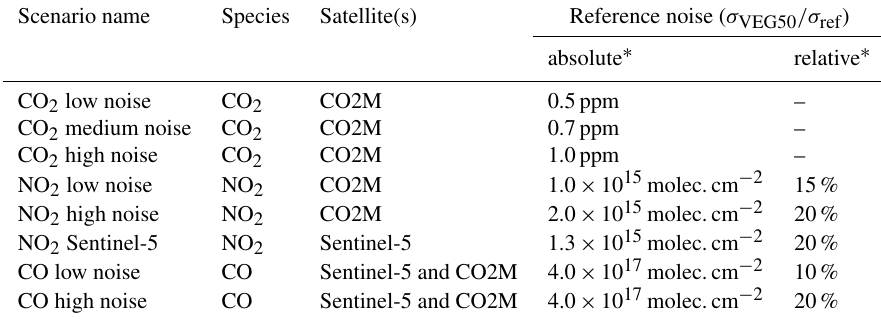
Figure 2. Spatial coverage of one CO2M satellite within its 11d repeat cycle (a) globally and (b) over Europe. The white square marks the COSMO-GHG model domain in which the number of overpasses is either one or two. The exact locations of the stripes are arbitrary and depend on the Equator starting longitude (here: 0 ◦ E) of the satellite. Table 4. Instrument uncertainty scenarios. VEG50 refers to a reference scene with a surface albedo of a vegetated surface and a solar zenith angle (SZA) of 50 ◦